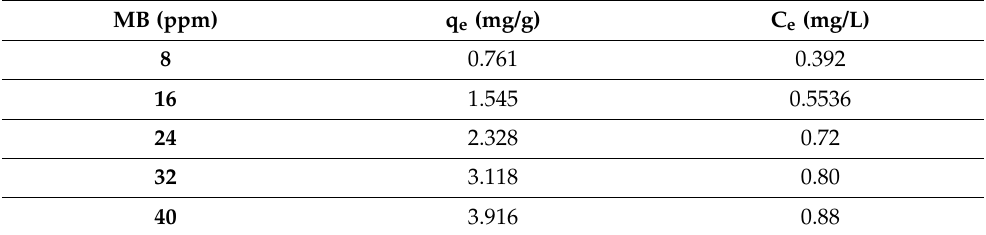
Table 5. The q e (mg/g) and C e (mg/L) values for different MB concentrations. MB (ppm)